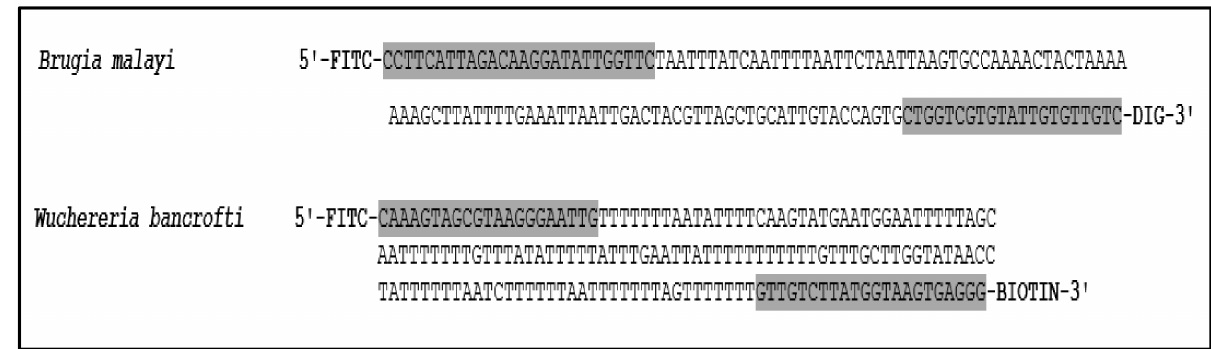
Figure 1. Alignment of Hha I repetitive noncoding DNA sequence of Brugia malayi (GenBank accession number M12691.1; position 132-277) and Ssp I repetitive noncoding DNA sequence of Wuchereria bancrofti (GenBank accession number L20344.1, positions 13-195). Gray areas indicate primers. For the DLFD, the Hha I and Ssp I primers were labeled with fluorescein isothiocyanate (FITC) and digoxin (DIG),